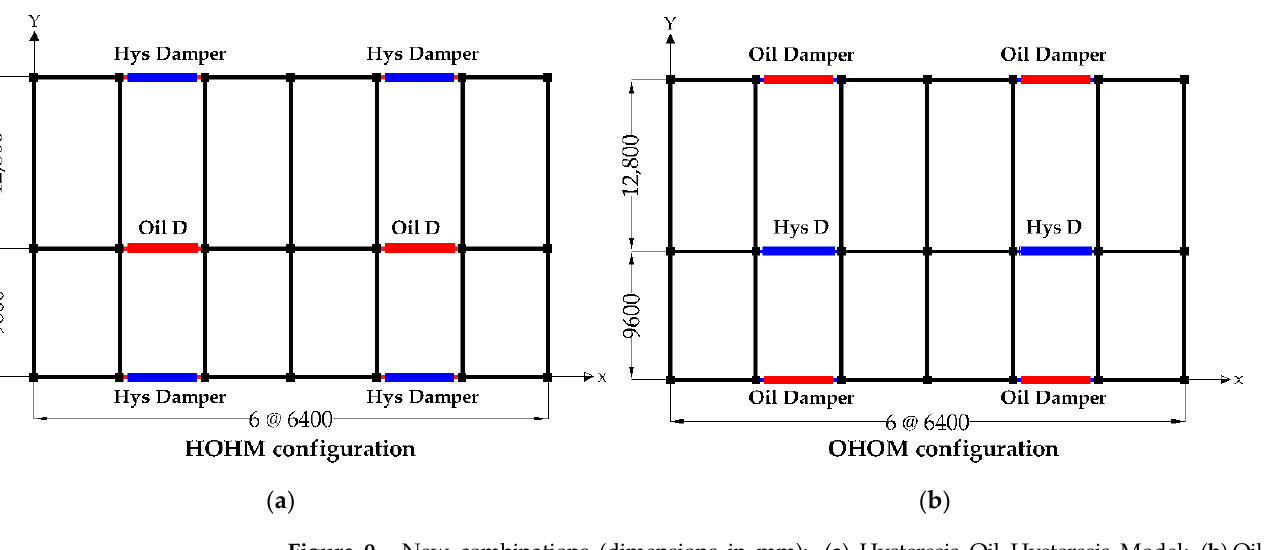
Figure 9. New combinations (dimensions in mm): ( a ) Hysteresis – Oil – Hysteresis Model; ( b ) Oil – Hysteresis – Oil Model.